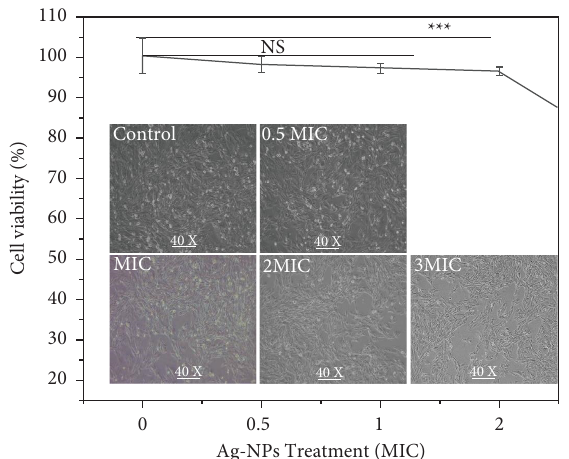
Figure 12: Determination of cell viability of Ag-NPs treated BHK- 21 cell using trypan blue exclusion